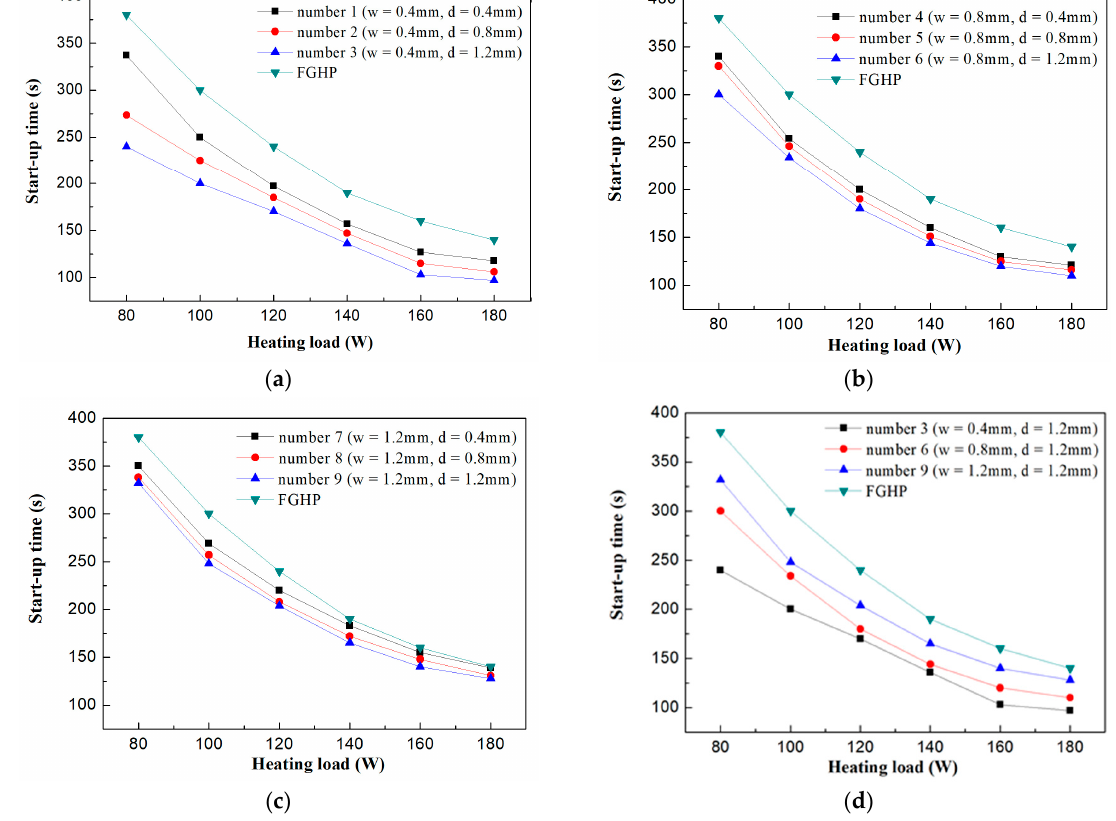
Figure 3. The start-up time of the FMGHPs and the flat gravity heat pipe (FGHP) at different heating loads: ( a ) FMGHPs 1–3 and FGHP; ( b ) FMGHPs 4–6 and FGHP; ( c ) FMGHPs 7–9 and FGHP; ( d ) FMGHPs 3, 6, 9 and FGHP.